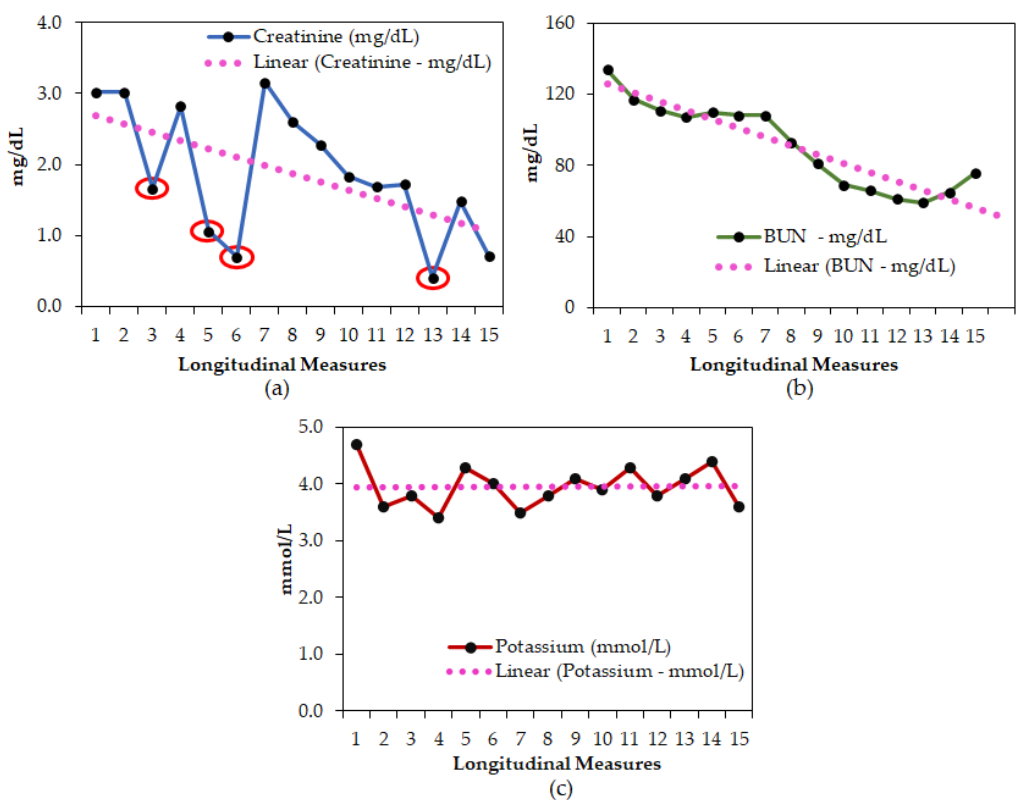
Figure 2. A representative longitudinal assessment of ( a ) sCr; ( b ) BUN; ( c ) K results from patient #1. Red circles in panel ( a ) indicate erroneous sCr results.